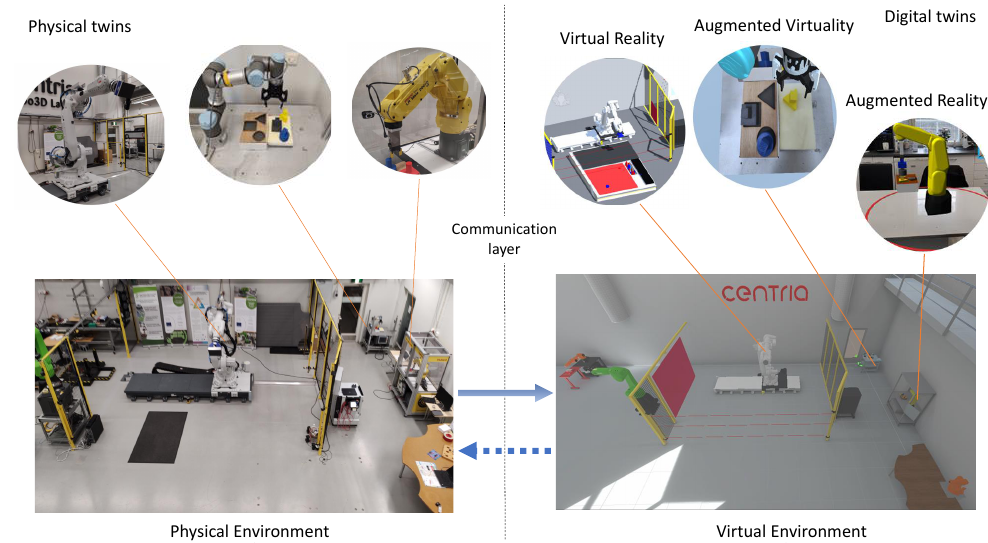
Figure 10. Physical and virtual training